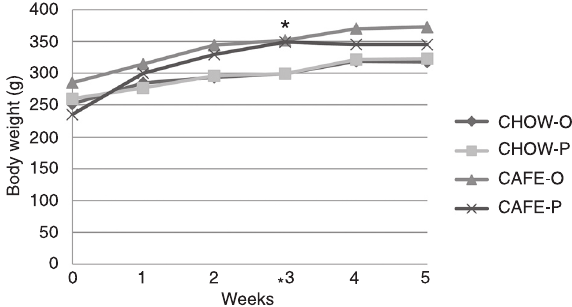
Figure 1. Body weight change in the various study groups from the beginning of the study, when the animals were 60 days old, until the day of sacrifice, when they were 95 days old. There was a significant increase in body weight in all groups when the mean final weight was compared to the mean initial weight (P < 0.05, paired t -test). *Beginning of the intervention. For group defini - tions, see legend to Figure 2.